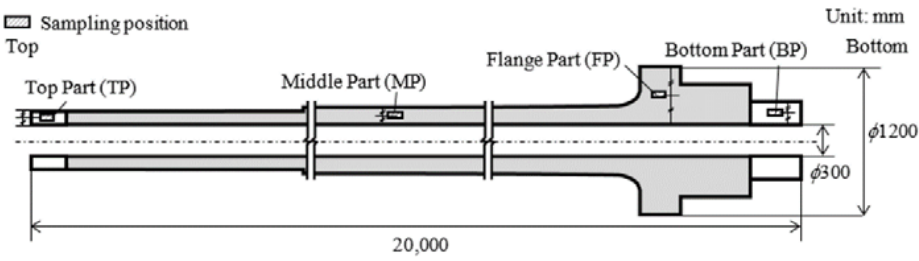
Figure 2. Schematic illustration of the long part product and sampling positions.